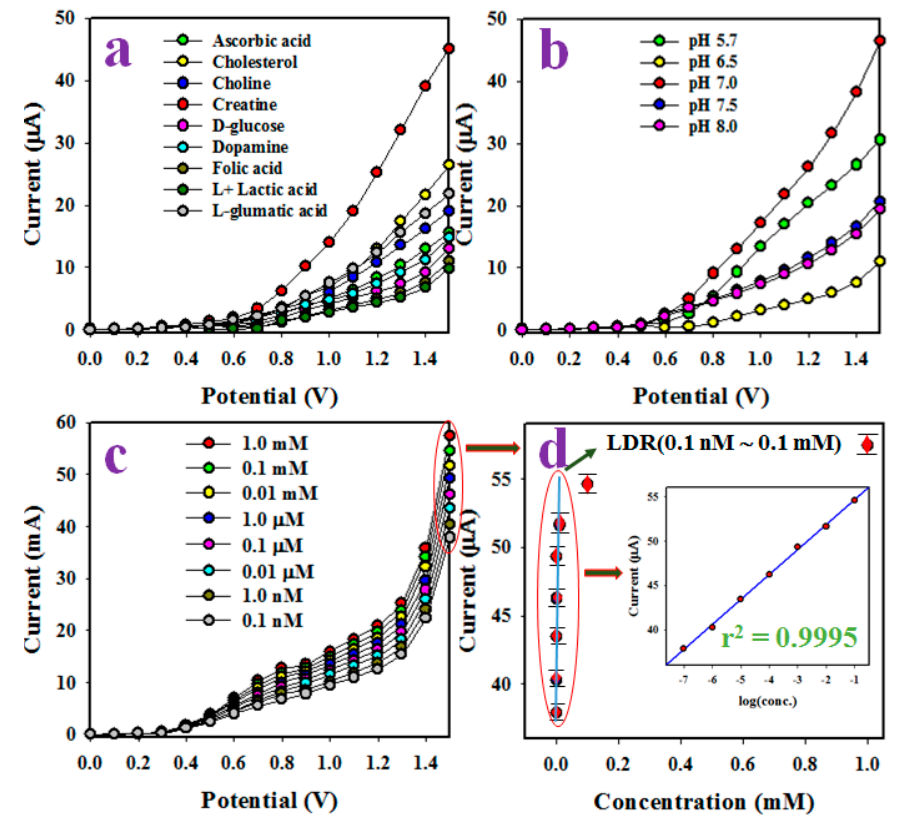
Figure 4. Characterization and evaluation of analytical performances of CMNO sensor probe for the detection of creatine (CA) chemical. ( a ) Selectivity analysis, ( b ) pH optimization, ( c ) electrochemical responses based on concentration variation of CA solution, and ( d ) calibration curve. Inset ((log (conc.) vs. current).